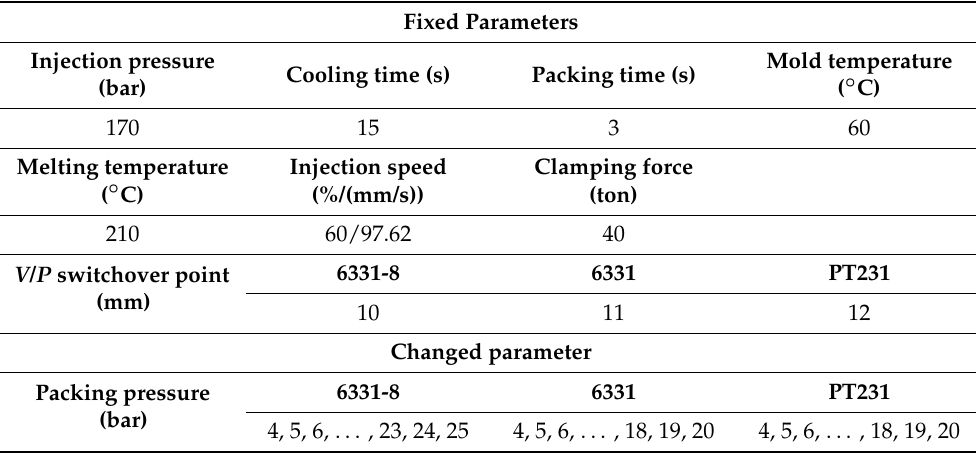
Table 4. Packing pressure experiment parameters.